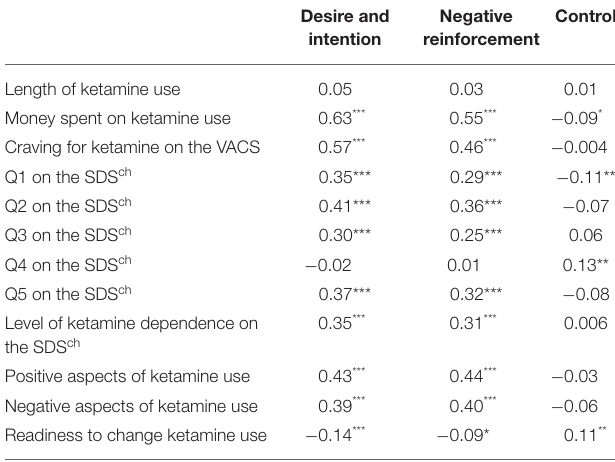
TABLE 2 | Correlations between the three subscales of the DDQ-K and ketamine-related outcomes: Pearson’s r . Desire and